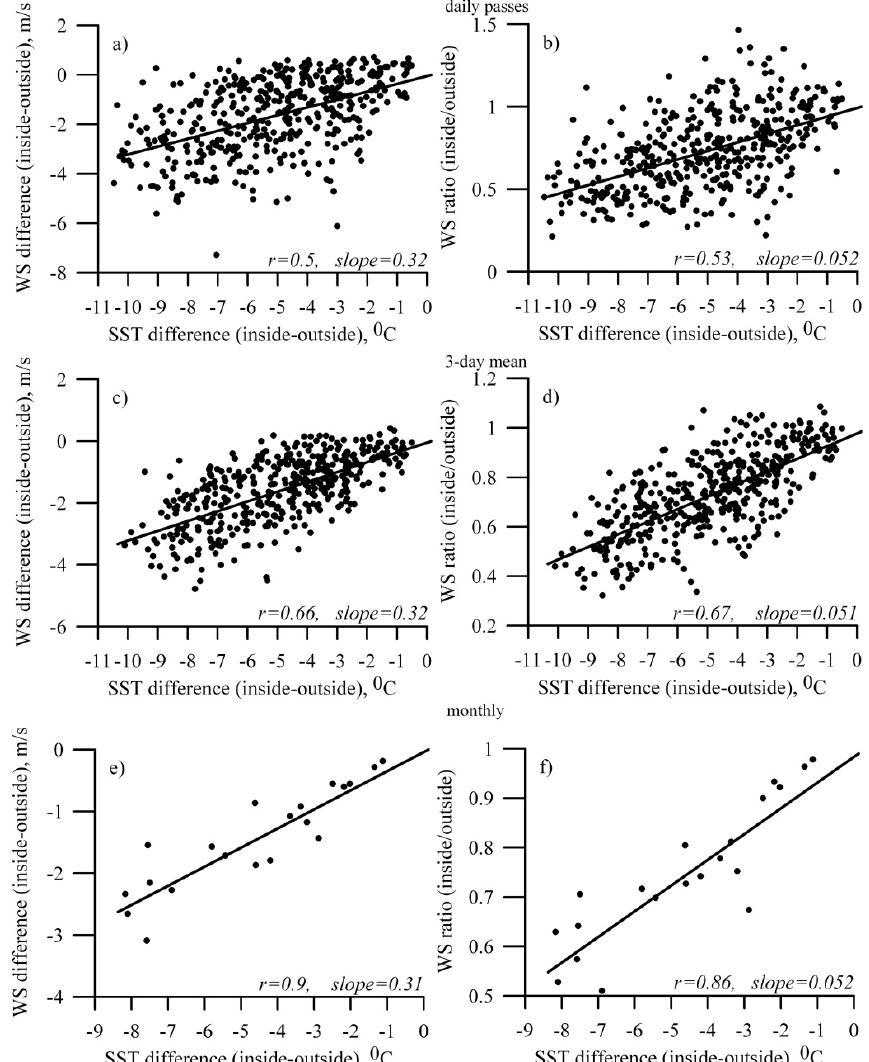
Fig. 4. Scatterplots of wind speed (WS) and SST difference (left panel) and wind speed ratio and SST difference (right panel) according to daily passes (top), 3-day average (centre) and monthly average (bottom) data for June–October 2006–2009.